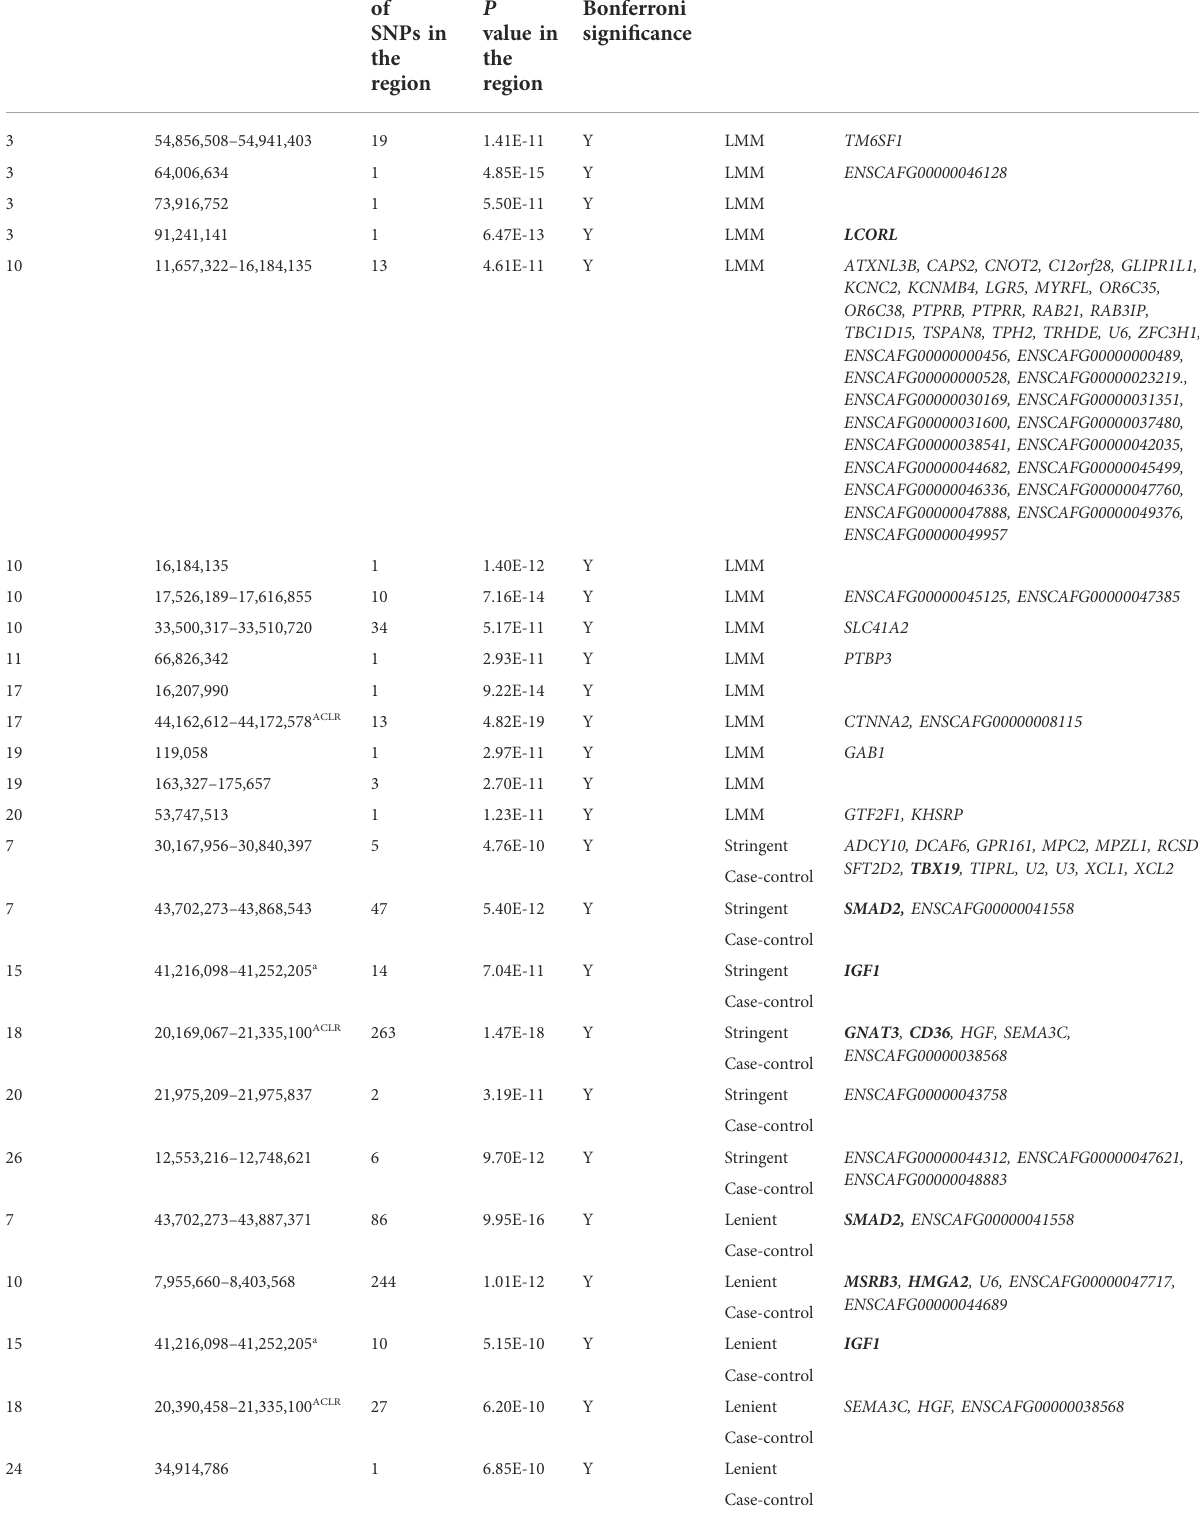
TABLE 5 Top candidate loci associated with hospital hip dysplasia in across-breed GWAS using breed phenotypes and four different association models. Chromosome